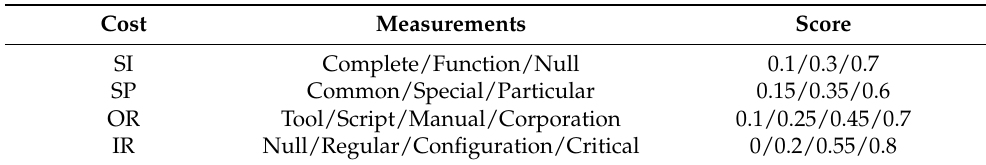
Table 4. Attack cost index score used by Luo et al. [65].